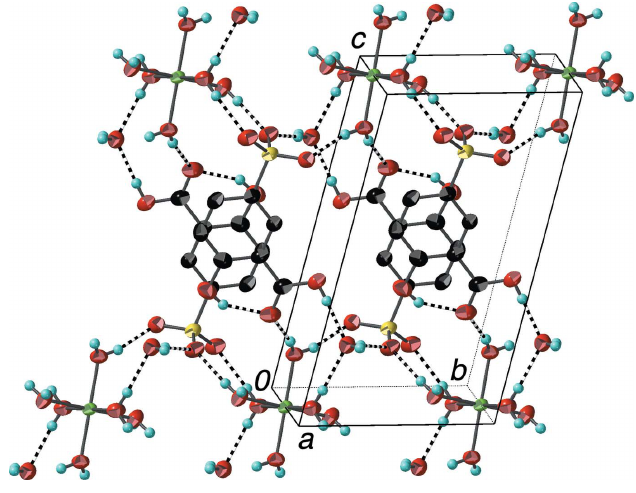
Figure 3 Packing diagram of (I) with the outline of the unit cell. The alternating layers of hexaaquanickel(II) cations and 3-carboxy-4-hydroxybenzene- sulfonate anions are evident. O—H (cid:2)(cid:2)(cid:2) O hydrogen bonds are shown as striped cylinders. H atoms bonded to C atoms have been omitted. Displacement ellipsoids are drawn at the 90% probability level.